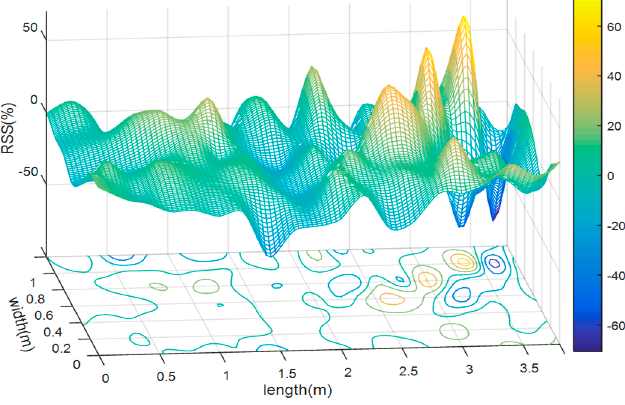
Figure 13. Fluctuation of a random received signal strength (RSS) sample against mean values.